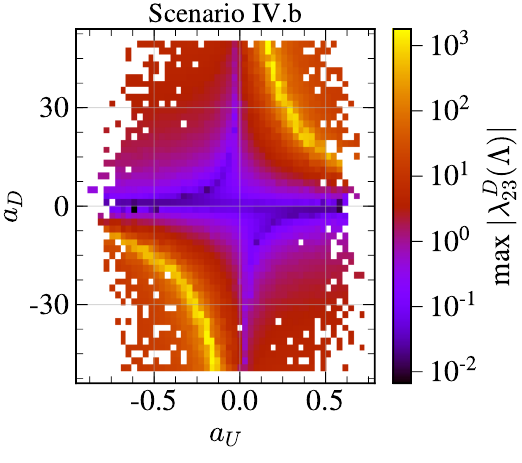
p = (cid:26) D v 2 = (2 m s m b ) at the scale (cid:3) = 10 10 GeV as a function of the 23 23